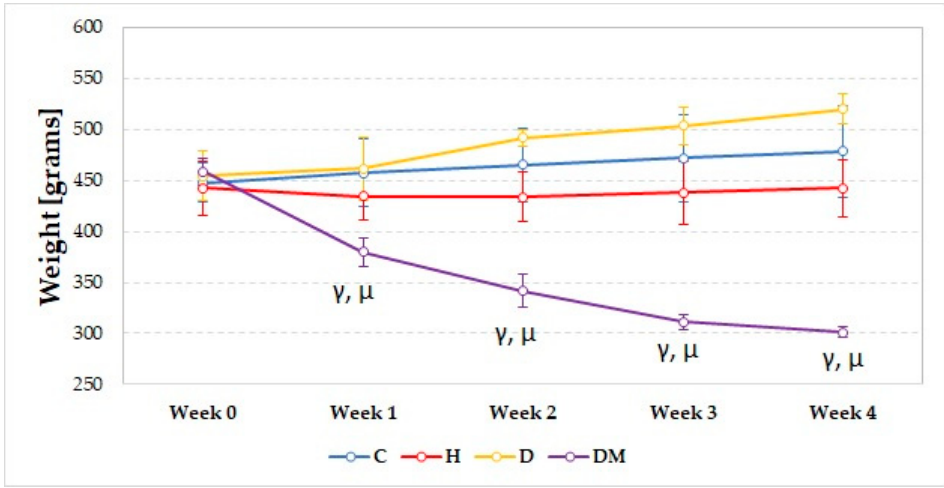
Figure 1. Evolution of weight of the rats; circles represent the median of each group. C = Control group, H = Hypertension group, D = Dyslipidemia group, DM = Type 1 Diabetes Mellitus group. The letter codes correspond to the p -values: < 0.020, γ DM compared to C, < 0.004, µ DM compared to D.